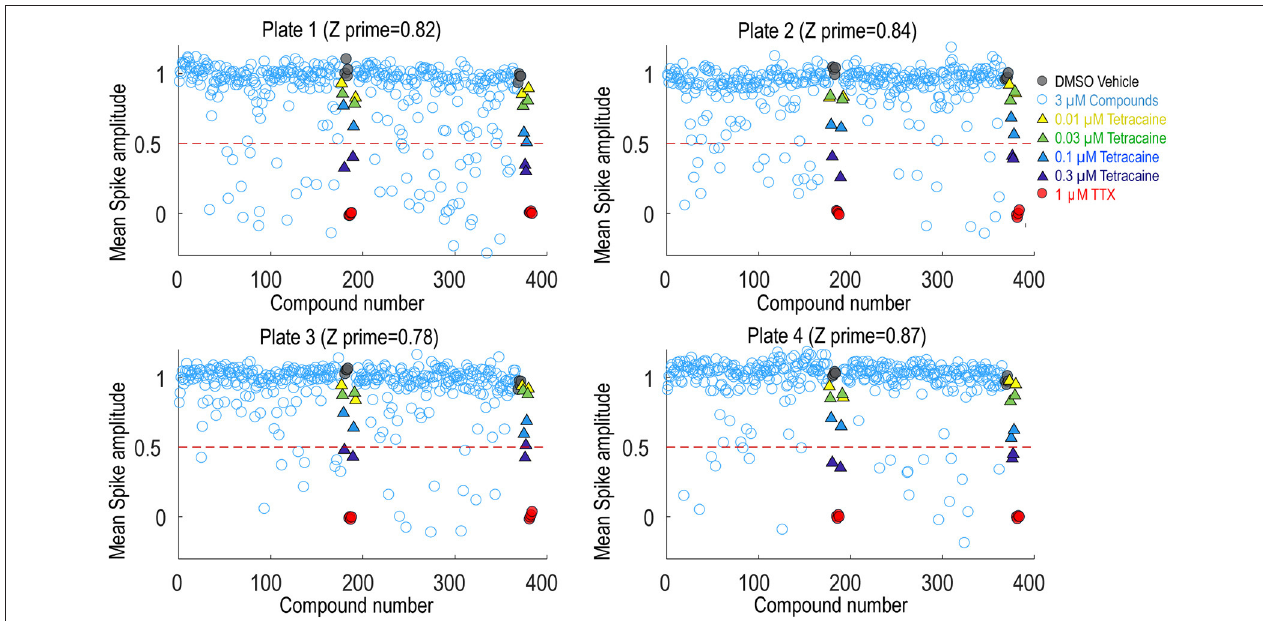
FIGURE 4 | Prestwick library pilot screen. Four 384-well plates from the Prestwick library were tested using Nav1.7 spiking HEK assay under 8mM bath potassium. The mean spike amplitude of individual wells is shown in scatter plots for each individual plate. DMSO vehicle was used as the negative control and 1 µ M TTX was used as the positive control. DMSO treated wells and TTX treated wells were used to calculate the Z ′ factor. On each plate, a four-dose tetracaine titration series was also included to monitor assay variability across different plates.